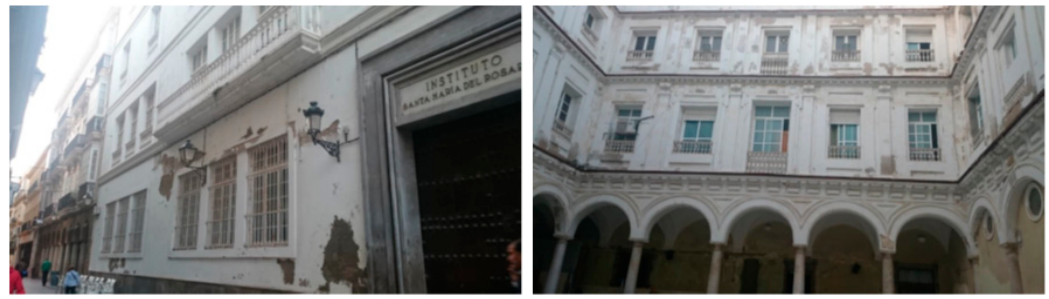
Figure 5. Facade of the building facing the street ( left ) and the inner courtyard ( right ).